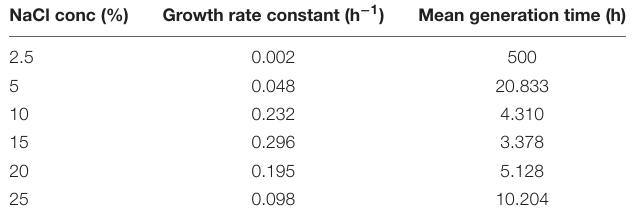
TABLE 1 | Growth statistics of Chromohalobacter salexigens ANJ207. TABLE 2 | List of the number of transcripts upregulated or downregulated in